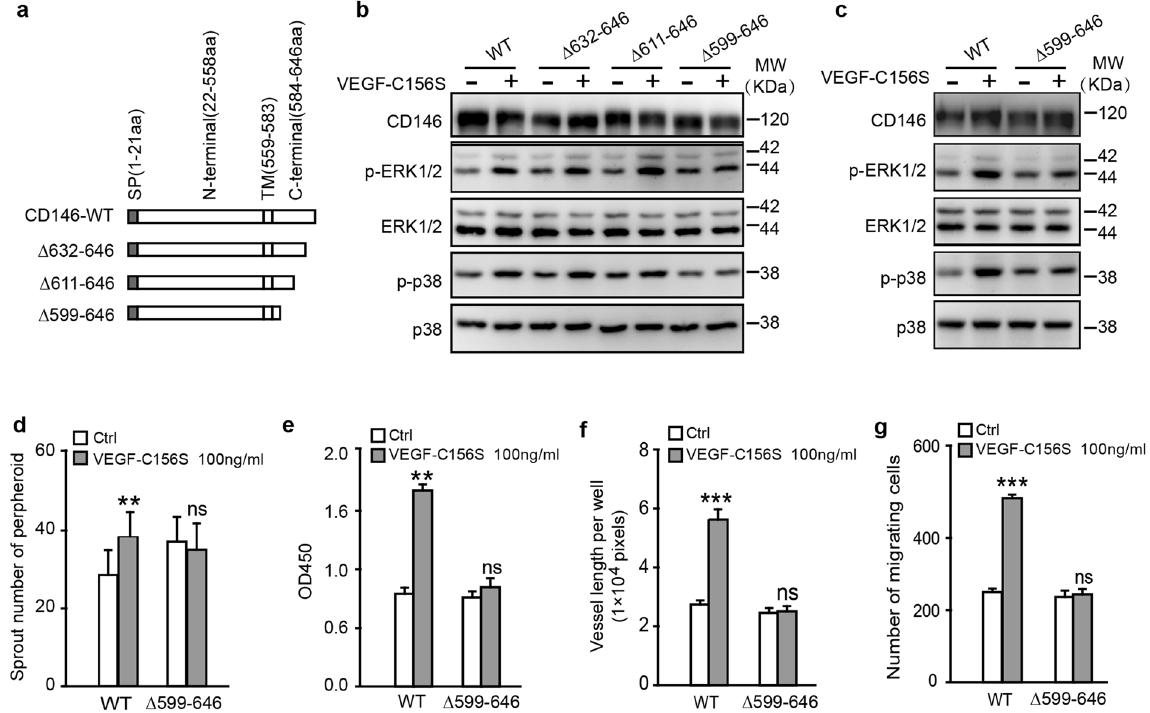
Figure 4. Functional cytoplasmic domain of CD146 in VEGF-C induced cell activation. ( a ) Diagrammatic representation of C-terminal truncations of CD146 at the intracellular domain. ( b ) Phosphorylation and expression of ERK1/2 and p38, elicited from VEGF-C156S, were analyzed by WB. HEK293 cells were transfected with plasmids encoding truncated versions of CD146 as shown in ( a ). ( c – g ) HDLECs transfected with plasmids encoding CD146-WT and CD146- ∆ 599-646 were subjected to signaling activation assay ( c ), spheroid sprouting assay ( d ), proliferation assay ( e ), tube formation assay ( f ) and transwell migration assay ( g ). VEGF-C was applied at the indicated concentration. Data were expressed as means ± SEM from 3 independent experiments (n = 12 in each group of c – g ,). Significant difference was determined by Student’s t- test ( * P <